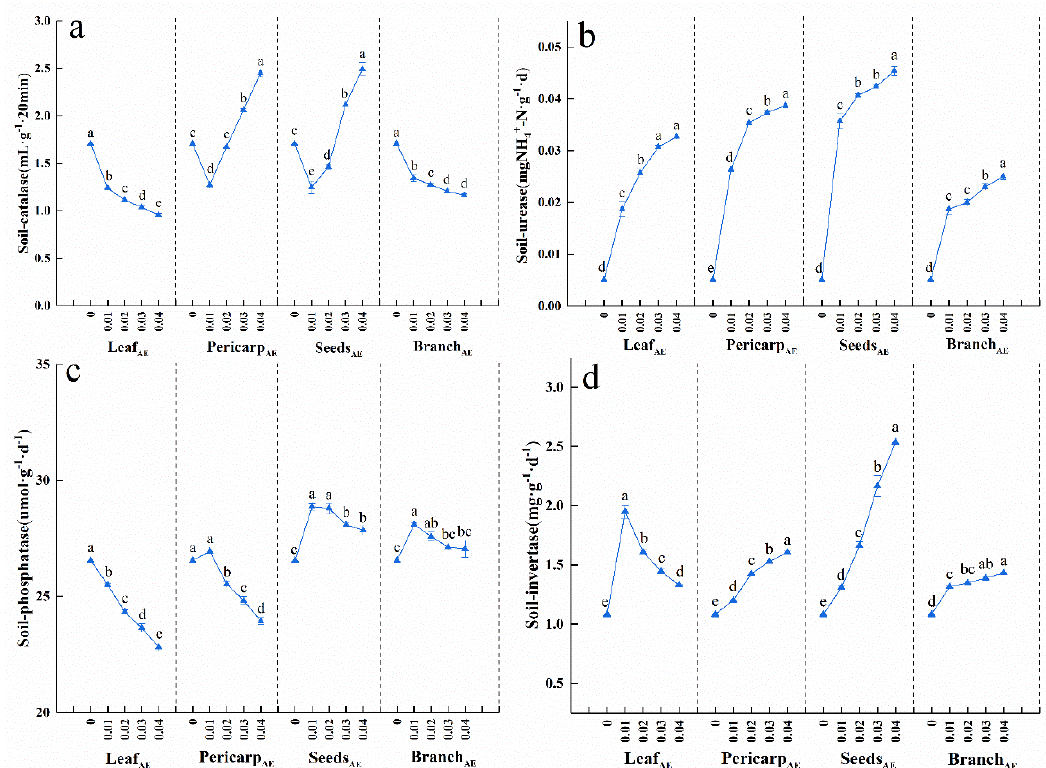
Figure 5. The catalase ( a ), urease ( b ), phosphatase ( c ), and invertase ( d ) contents in soil planted with C. migao seedlings after litter aqueous extract treatments for 210 days. The x axis denotes the concentration of the aqueous extract and the y axis denotes the content. Values are expressed as mean ± SE. The values marked with different letters are significant at p < 0.05 (Duncan’s test).